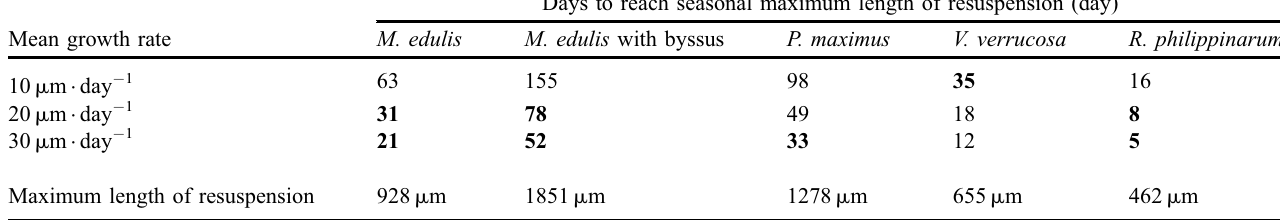
Table 2. Theoretical maximum temporal windows of secondary migration for the 4 species and mussels ’ recruits producing byssus. Three different growth rates are considered and a size at metamorphosis and arrival on the sediment of 300 m m. Smoothed maximum length of resuspension data has been used (5 days moving average). Values in bold correspond to pertinent growth rates of each species according to the